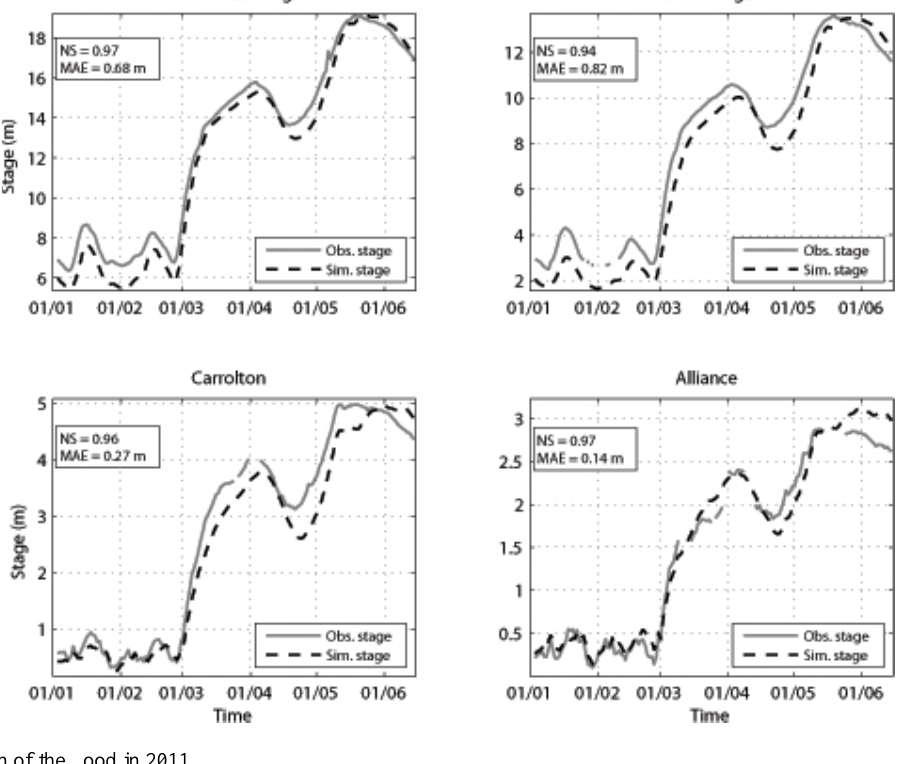
Figure 3. Validation of the flood in 2011.